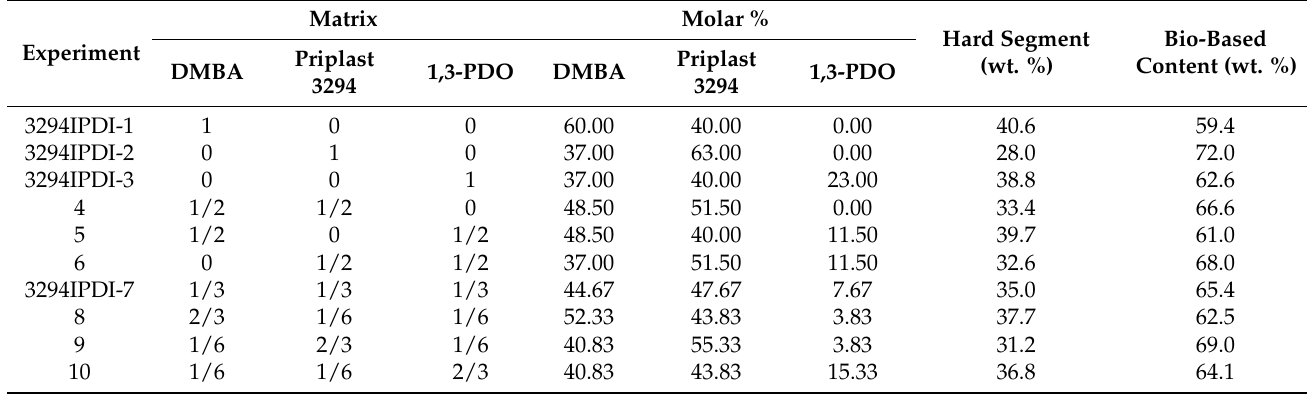
Table 1. The overall simplex design table. Experiments that have been performed in this work are highlighted in grey.